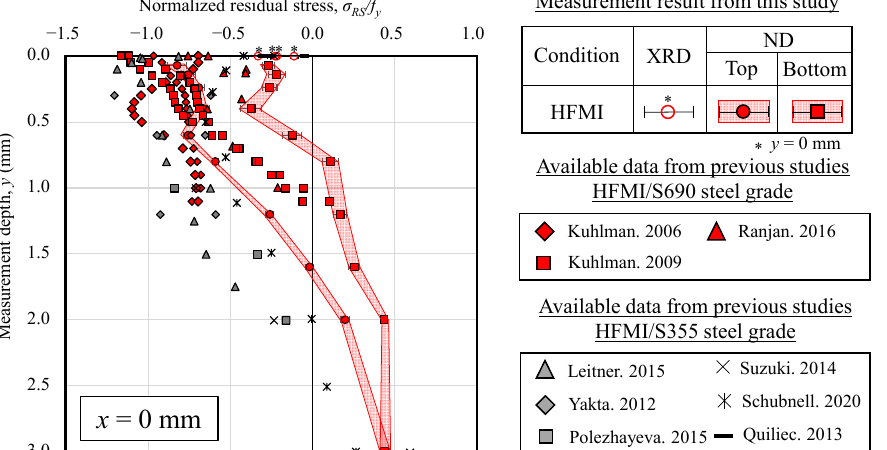
Figure 6. Comparison between measurement results and existing data for HFMI specimens and for two different steels at x = 0 mm.